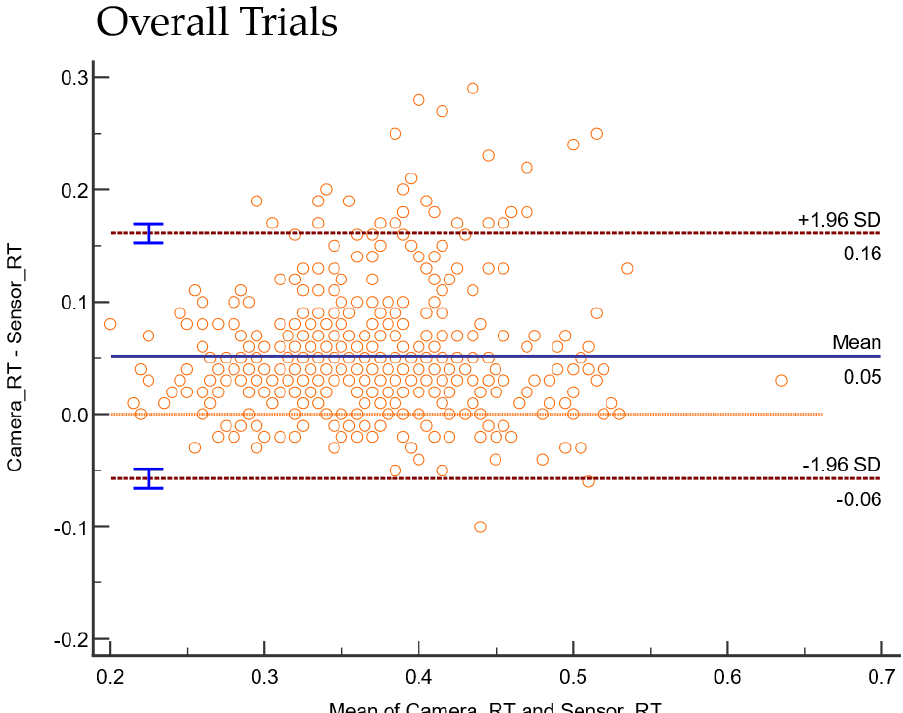
reported a longer mean RT (bias) during both conditions by 0.05 s.